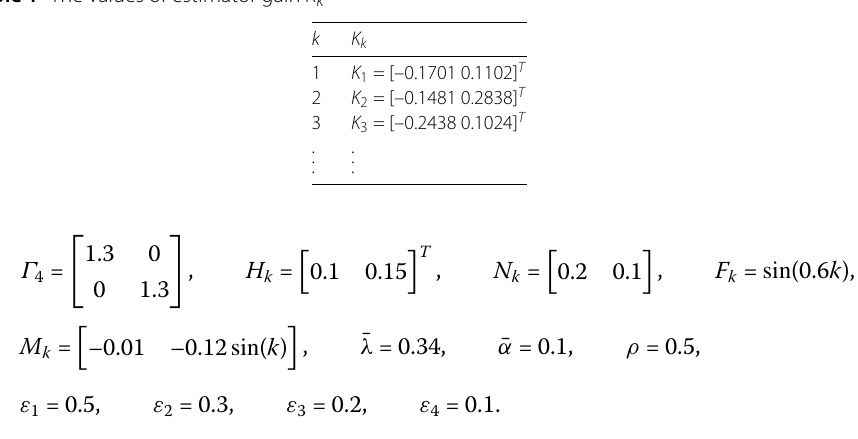
Table 1 The values of estimator gain K k